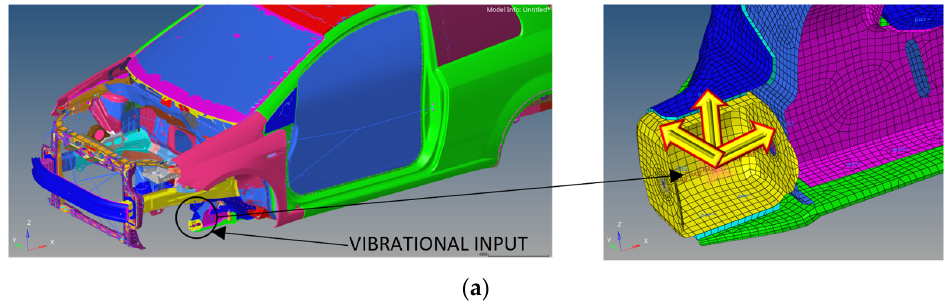
Figure 31. Position of virtual microphone 2 (driver’s ear) and 5 (passenger’s ear).